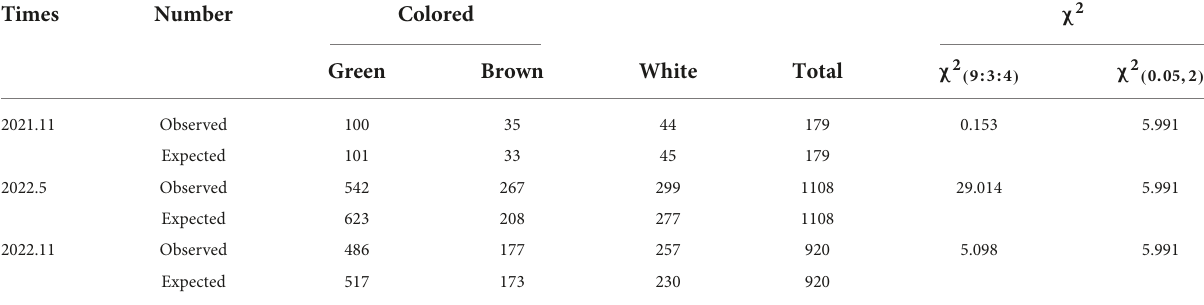
TABLE 1 Chi-square ( χ 2 ) analysis of the segregation of pericarp colors in the F 2 generation derived from a cross between LM8 and